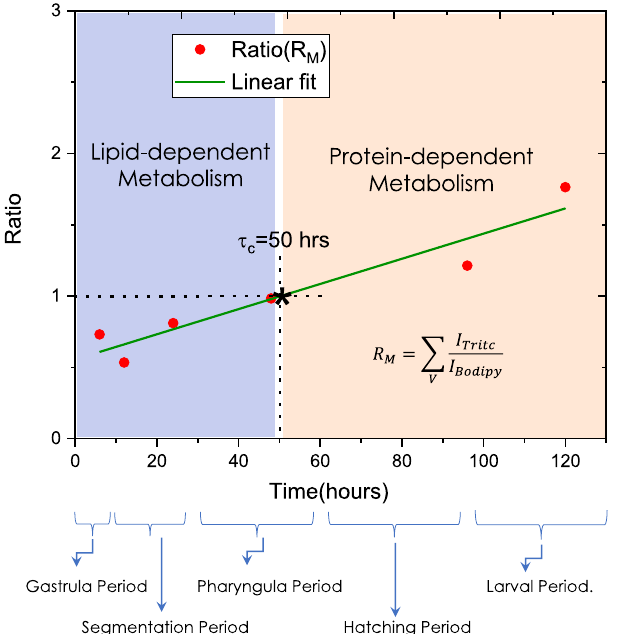
Figure 7. Mean ratio plot for determining the transition from lipid based metabolism to protein based metabolism. The data points are obtained by integrating the ratio of TRITC and BODIPY (representing, muscle and yolk-sac respectively in Zebrafish). A linear fit is used to represent the data. The region to the left of the critical transition time ( τ c ) is labeled as lipid-based metabolism and the region to the right of τ c as protein- based metabolism. The critical transition time occurs in the Pharyngula period (approximately at 50 h after